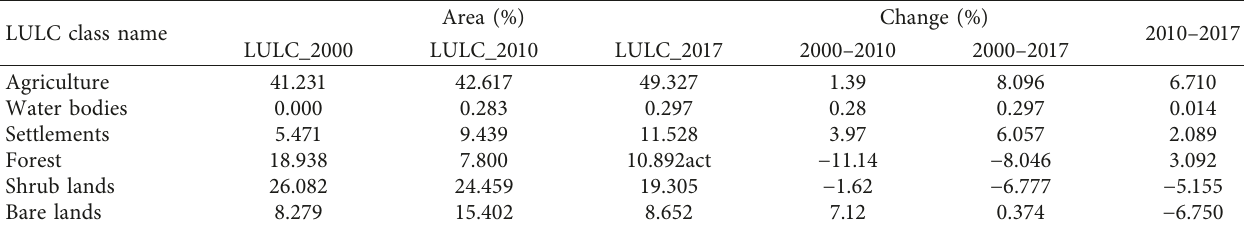
Table 6: Percentage distributions and area coverage of the classified LULC types from 2000 to 2017.